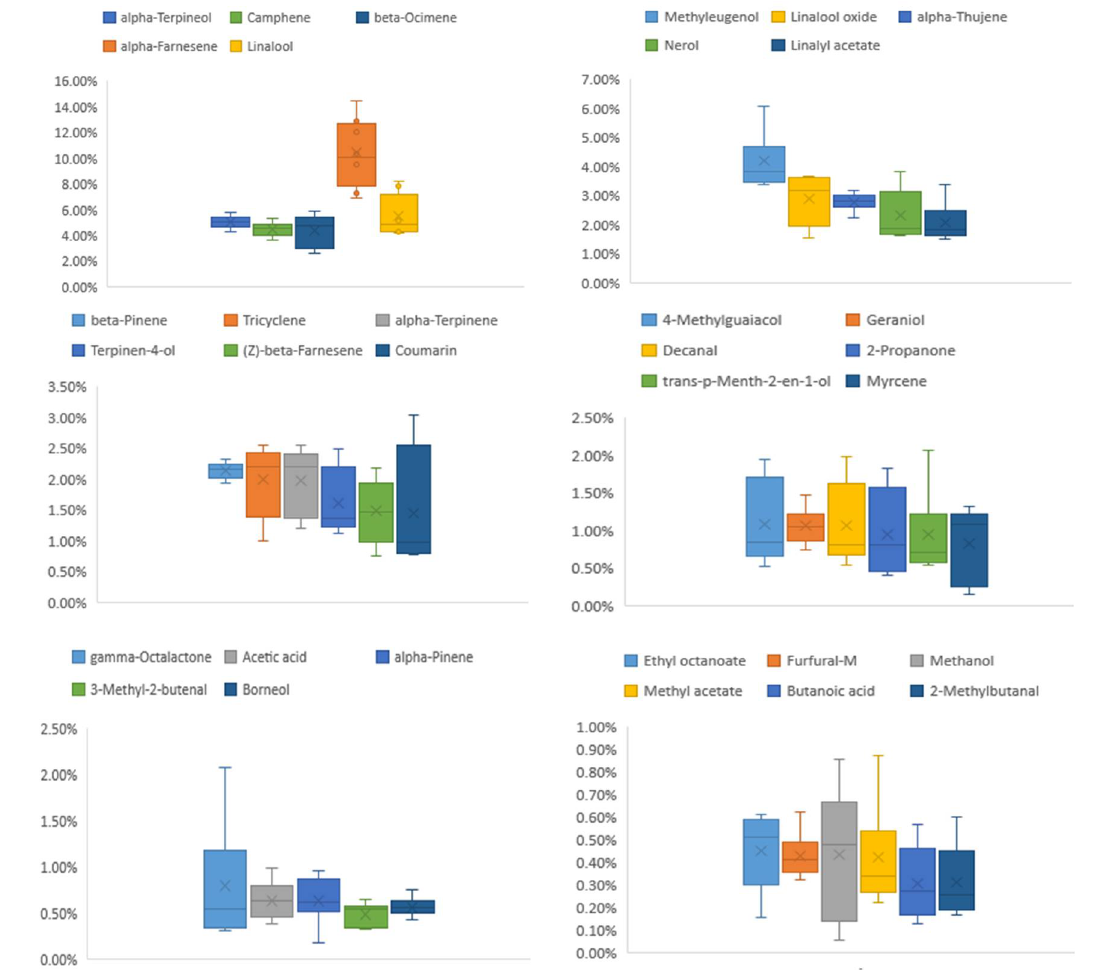
Figure 2. Relative contents of volatile compounds in Qu Aurantii Fructus. Table 1. The specific information and relative contents of volatile compounds in Qu Aurantii Fruc- tus.